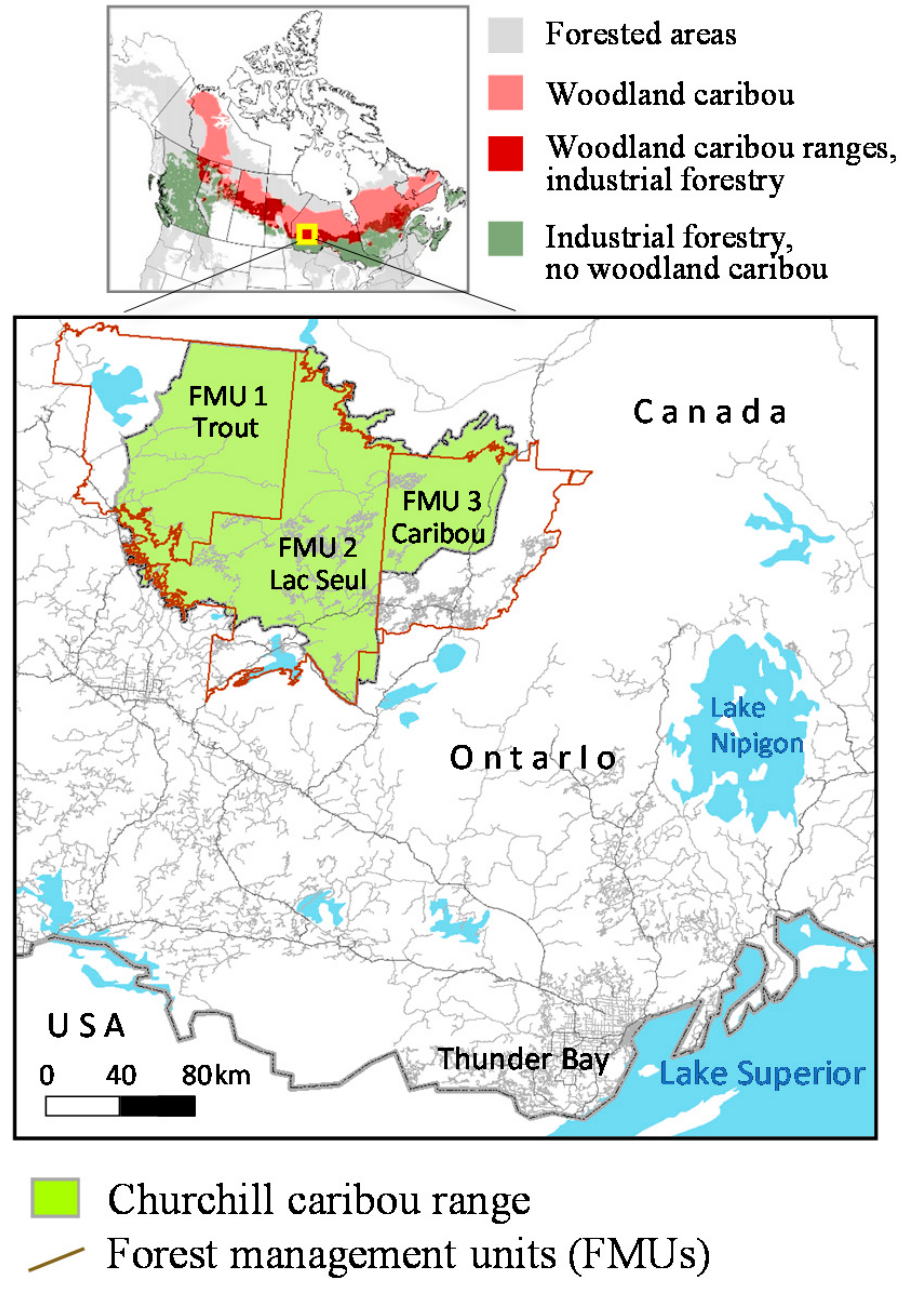
Figure 1. Case study area: Churchill caribou range, Ontario, Canada.